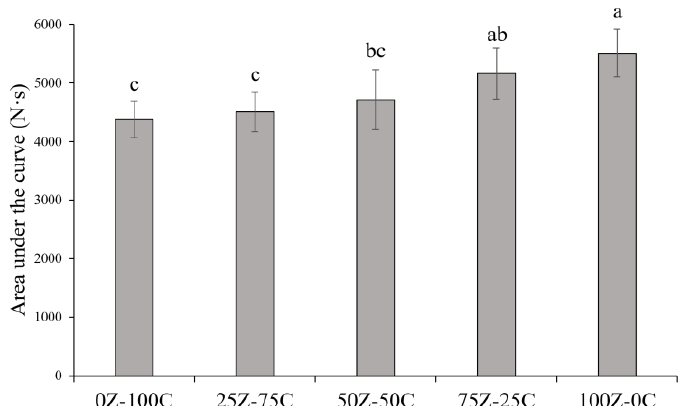
Figure 7. Area under the force–time curve from time 0 to 10 s of plant-based cheese alternative samples. Different letters (a–d) indicate significant differences between samples ( p < 0.05).